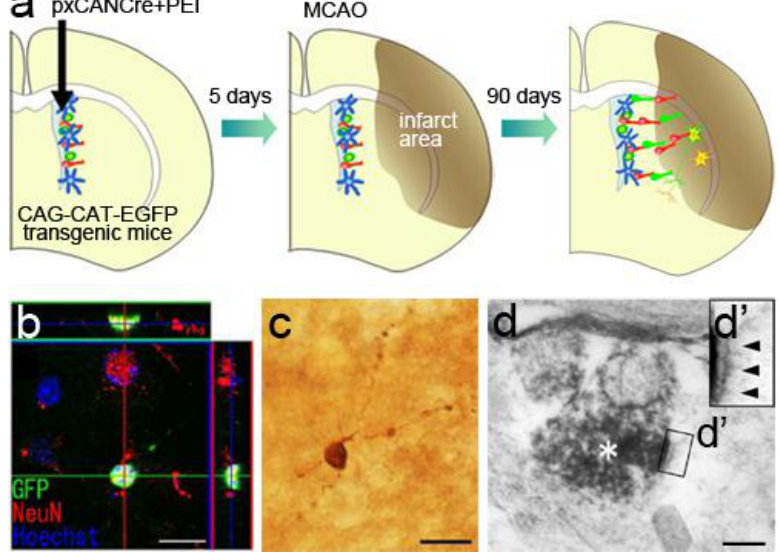
Figure 6. Endogenous NSC-derived neuronal regeneration. ( a ) Schematic drawing of the experimental procedure. The pxCAN Cre plasmid was injected into the lateral ventricle 5 days before MCAO, then the fate of GFP-labeled new neurons generated in the SVZ was detected 90 days after MCAO; ( b ) Confocal 3D reconstruction image of a GFP (green)-labeled cell expressing the mature neuronal marker, NeuN (red). Ninety days after MCAO, 29% of the SVZ-derived GFP-positive cells around the infarcted area expressed NeuN, a specific marker for mature neurons. Scale bar: 20 µm; ( c ) A GFP-positive cell exhibiting a neuronal morphology. Scale bar: 20 µm; ( d ) An electron micrograph showing a GFP-positive axon (asterisk) containing presynaptic vesicles. A higher-magnification view of the region of the boxed area (d’) shows the postsynaptic density (arrowheads). Scale bar: 0.5